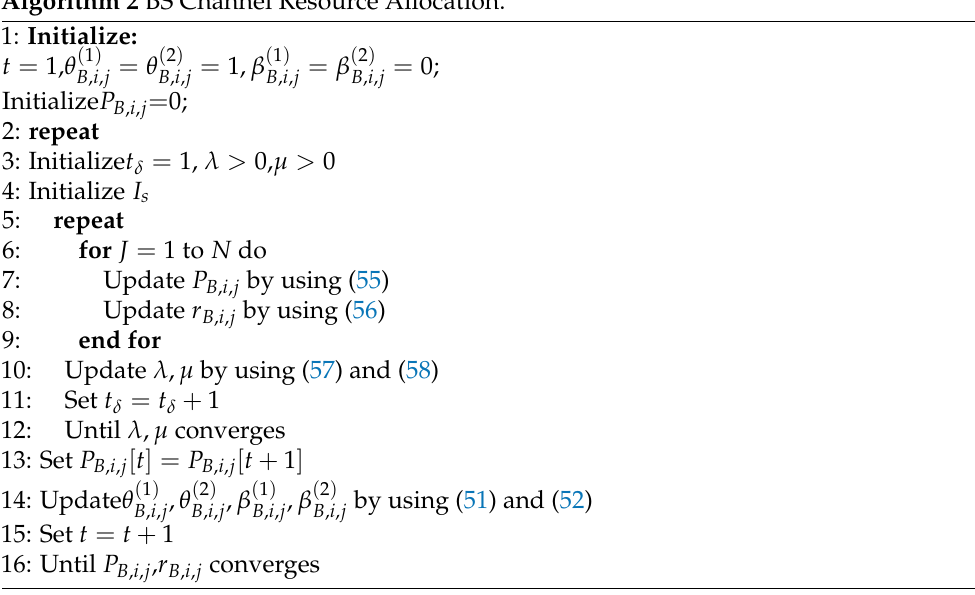
Algorithm 2 BS Channel Resource